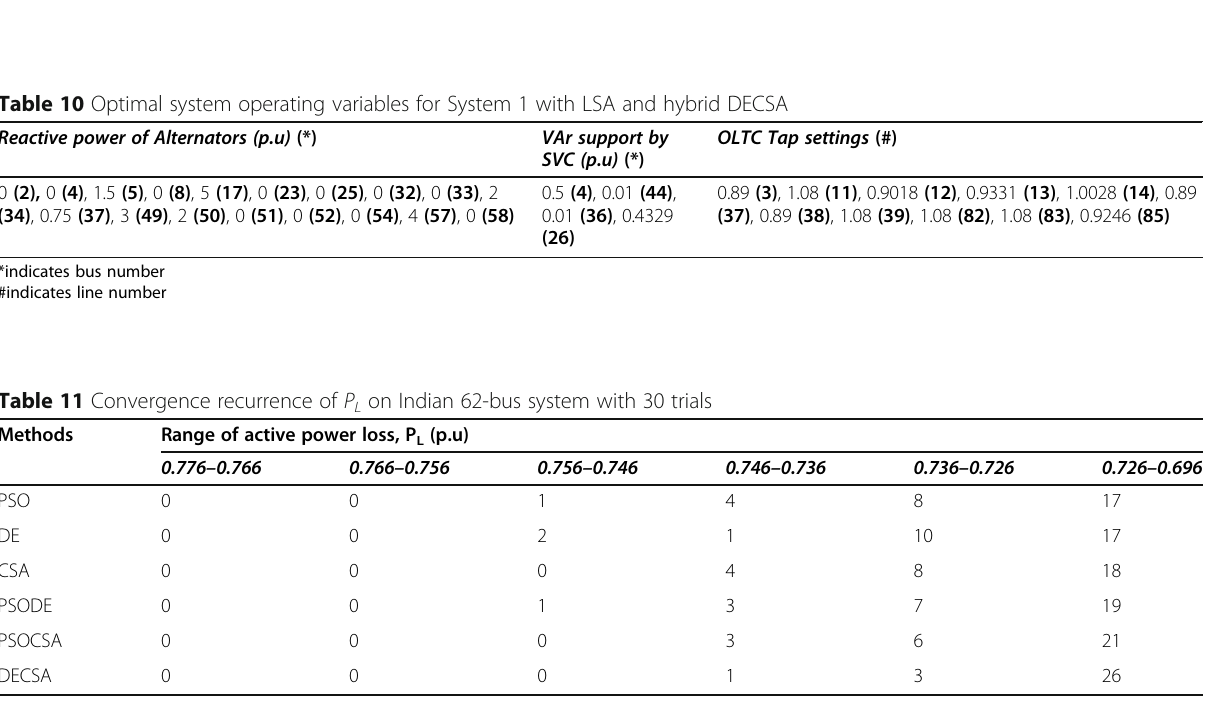
Table 10 Optimal system operating variables for System 1 with LSA and hybrid DECSA Reactive power of Alternators (p.u) (*) VAr support by